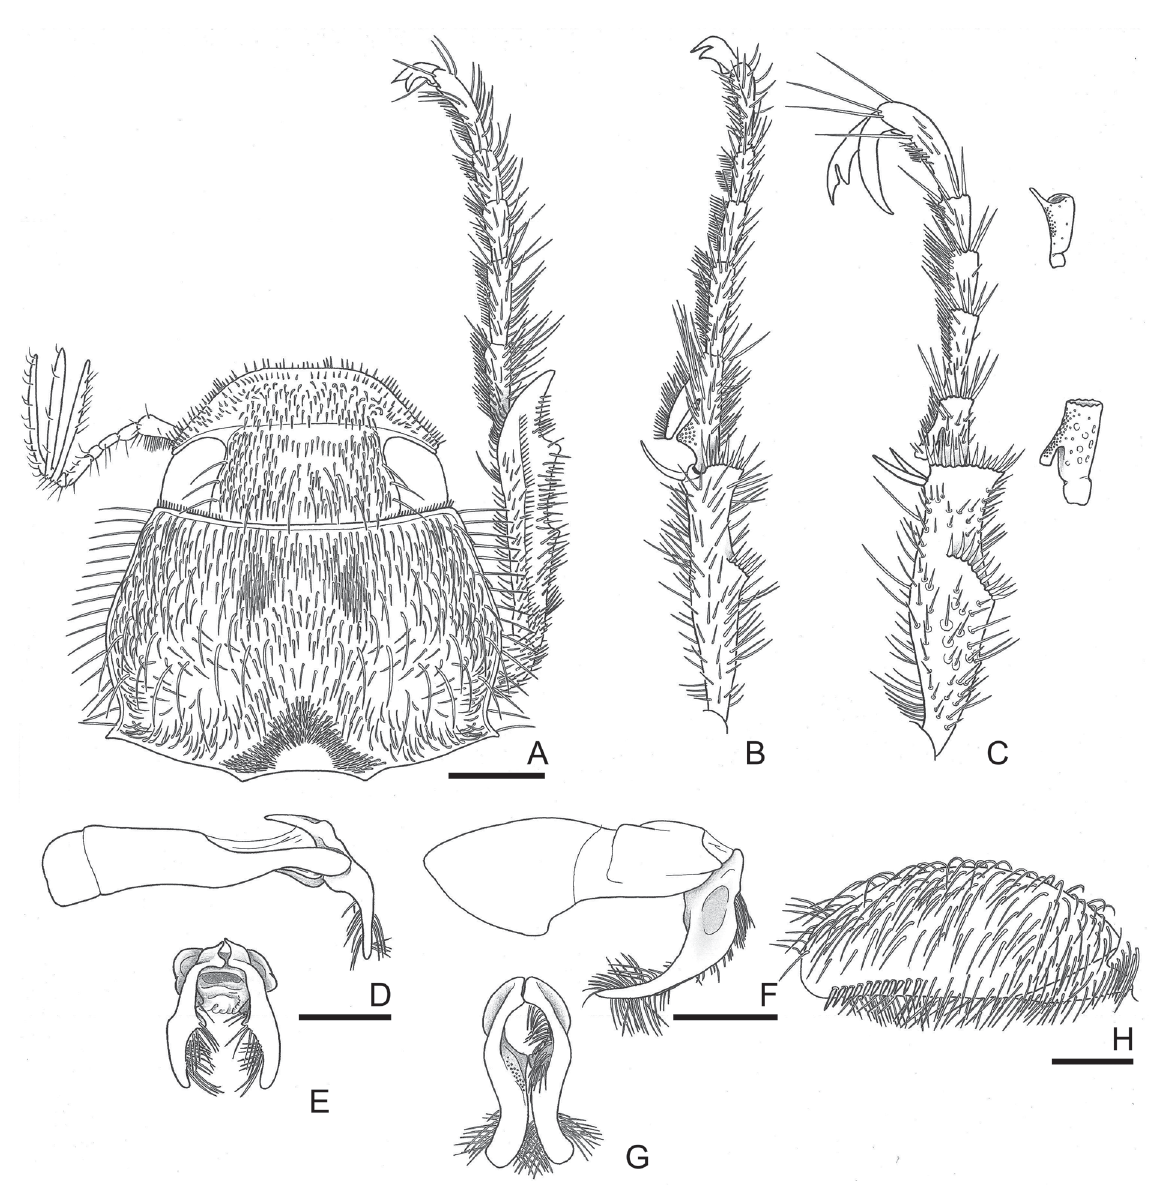
Fig. 13. ♂♂. A . Head–prothorax dorsal, tarsus rotated laterally to apex. B–C . Mesotibia−tarsus (C, with details of tarsomere I and IV). D−G . Aedeagus (lateral, parameres apex). H . Metafemur. A–B , D–E . Pseudoserica marmorea Guérin-Méneville, 1831. C , F−H . Mallotarsus spadiceus Blanchard, 1850. Scale bars =